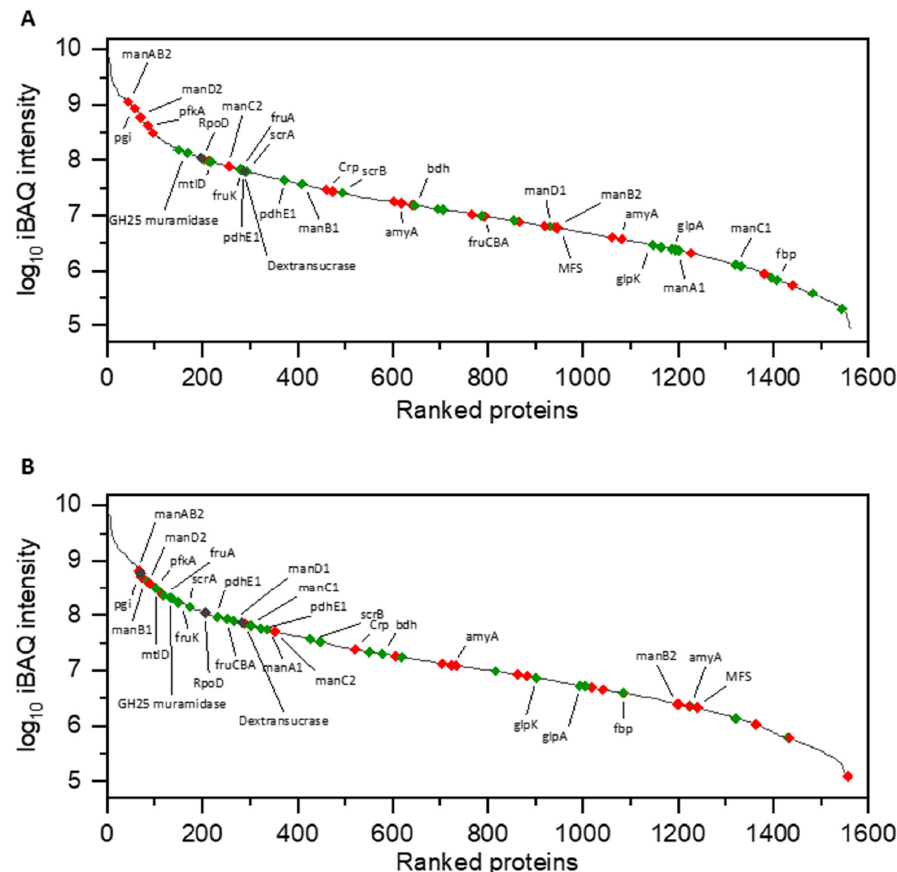
Figure 2. MS intensity ranking of identified proteins in cellular proteomes of cultures treated with glucose ( A ) and sucrose ( B ). Red color = significantly down-regulated in sucrose, green color = significantly up-regulated in sucrose (see Table 1). amyA = glucohydrolase; manA-D = PTS man ; pgi = glucose-6-phosphate isomerase; pfkA = 6-phosphofructokinase; mtlD = mannitol-1-phosphate 5-dehydrogenase; fruK = 1-phosphofructokinase; fruA + fruCBA = PTS fru ; scrA = PTS scr ; pdhE1 = pyruvate dehydrogenase E1 subunits; Crp = catabolite repression protein; scrB = sucrose-6-phosphate hydrolase; bdh = butanediol dehydrogenase; MFS = sucrose-specific MFS-transporter; glpA = glycerol-3-phosphate dehydrogenase; glpK = glycerolkinase; fbp = fructose-1,6-bisphosphatase.